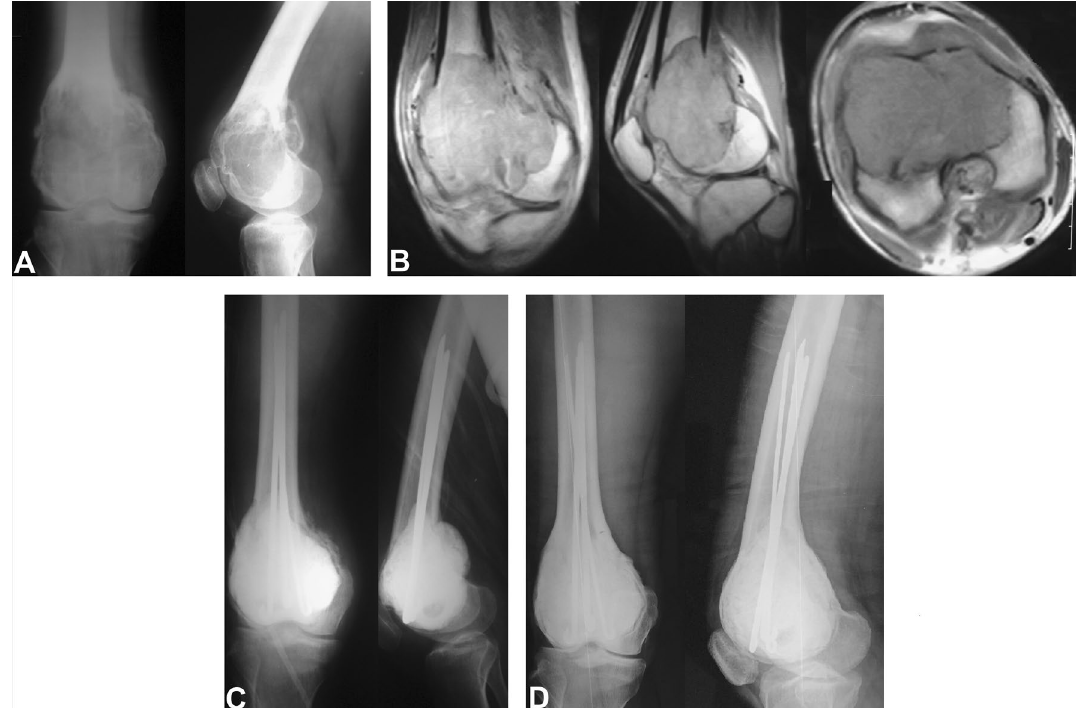
Fig. 3 A 28-year-old male with giant cell tumor and pathologic fracture of the distal femur treated with curettage and cementation with fixation using rush pins. A Preoperative AP and lateral X-rays. B Preoperative coronal, sagittal, and axial MRI cuts. C Immediate postoperative AP and lateral X-rays. D Ten-year follow-up AP and lateral X-rays with KL grade 3 arthritic